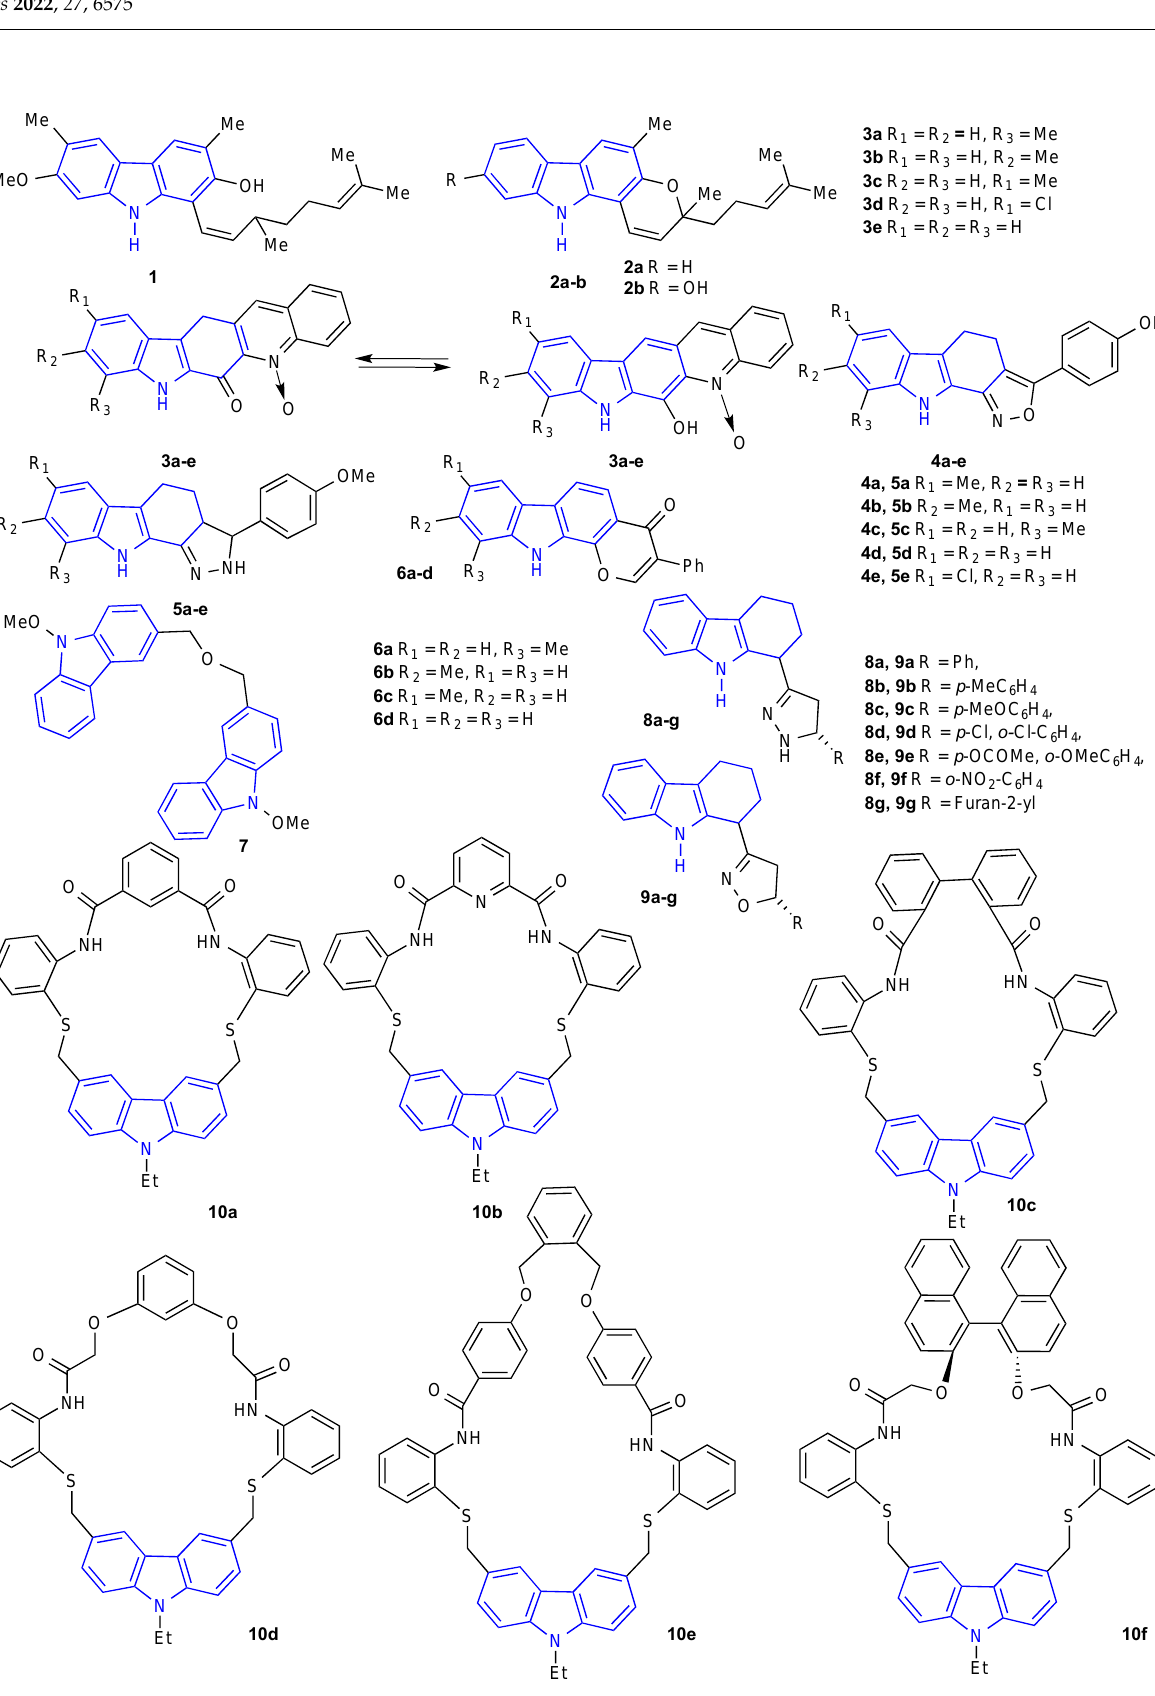
Figure 3. Structures of the reported carbazole derivatives from 1999 to 2009 .